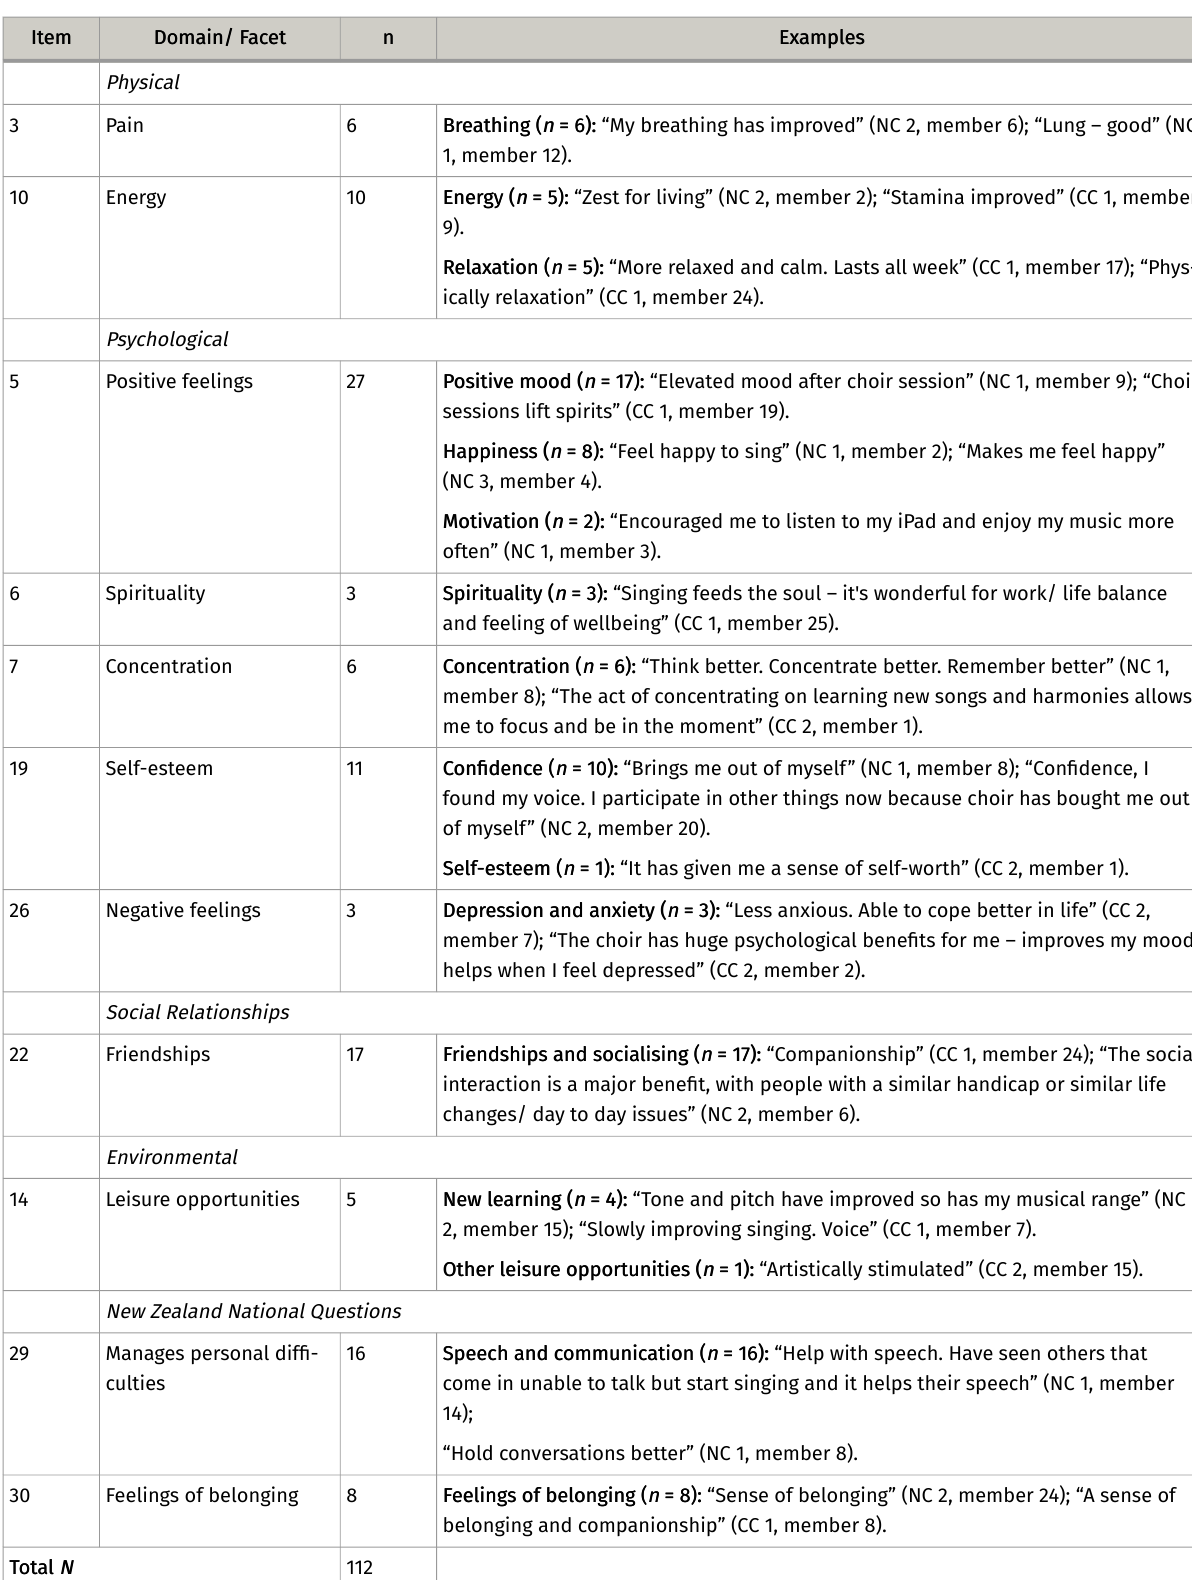
FFriendships and sociariendships and socialising (lising (nn= 17):= 17): “Companionship” (CC 1, member 24); “The social interaction is a major benefit, with people with a similar handicap or similar life changes/ day to day issues” (NC 2, member 6).